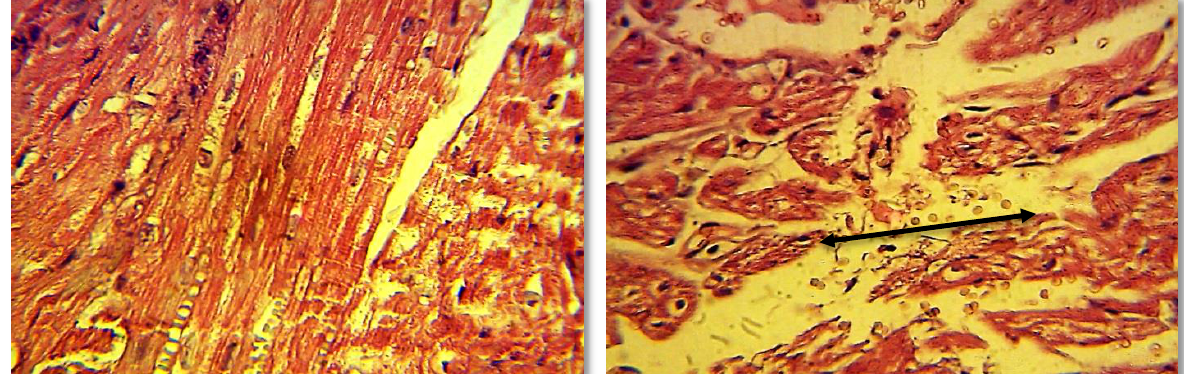
Figure,2: Section in the cardiac muscle of rabbit treated with methionine over load (T1) for 42 day show edema, RBCs and few neutrophils infiltration between cardiac muscle bundle, in addition to vacuolar degeneration of muscle cells